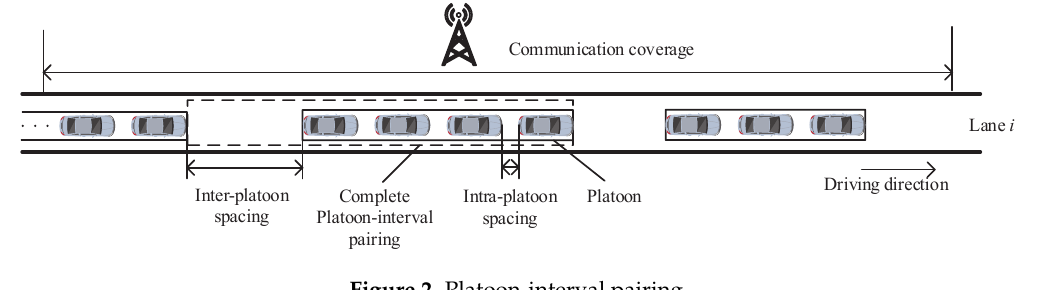
Figure 2. Platoon-interval